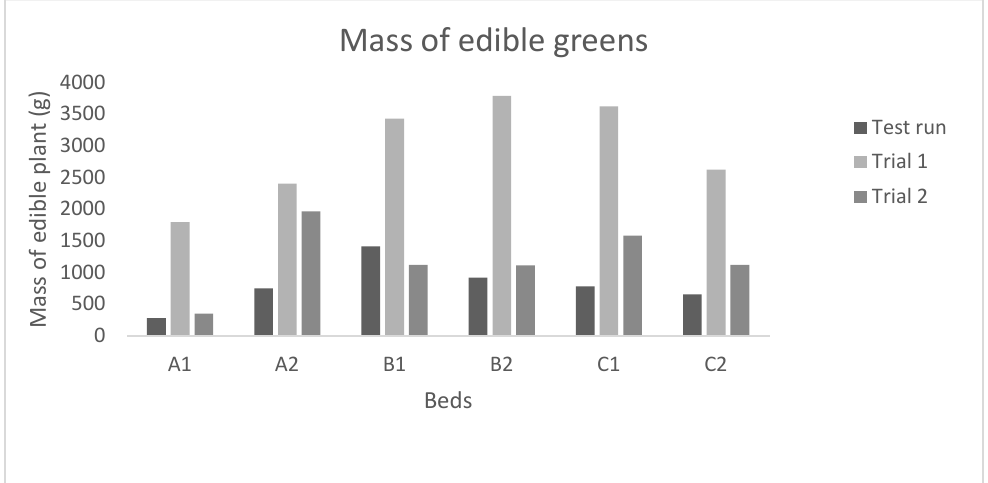
Figure 6. Pak-choi yield (biomass, fresh weight of whole plants without roots) from System 4. The test run included the initial stages of the system where nutrients were still accumulating, and the bacteria were still settling in the system. Trial 1 was during the summertime when the ambient light was present for 22 h / day. Trial 2 was during the winter with ambient light only present for 4 h / day and low indoor temperature. Table 6. Harvest results from the systems. Plants grown in Systems 2 and 3 were mixed herbs and leafy greens, whereas in System 4 pak-choi was grown as a single crop (see Table 2). Feed Feed Fish Biomass Plant Plant to Feed Plant to System/Phase Conversion (kg) Increase (kg) Yield (kg) Conversion Ratio Fish Ratio Ratio System 2 2.9 3.2 0.9 3.8 1.3 1.2 System 3 4.0 System 4/Test System 4/Trial 1 6.0 4.4 1.4 17.7 3.0 4.0